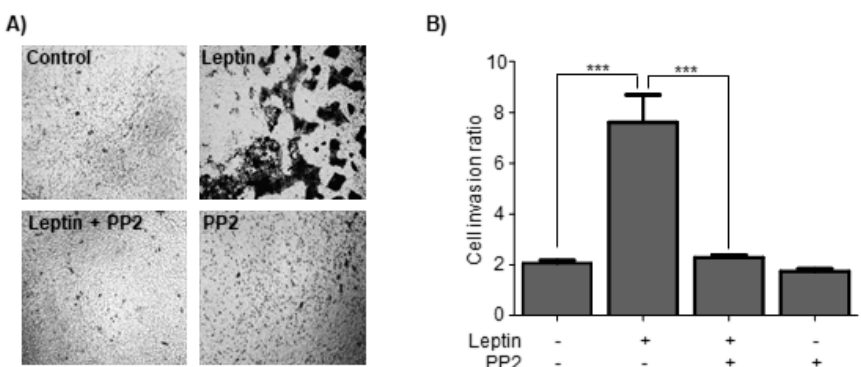
Figure 7. Leptin induce invasion in MCF10A cells in a Src-dependent manner. ( A ) Representative light microscopy images of invasion assays of MCF10A cells pre-treated with AraC and grown in the presence or absence of leptin, and the Src inhibitor PP2. ( B ) Quantitative analyses of the invasion assays presented in ( A ); the values represent the mean ± SD of three independent experiments, and are expressed as a cell invasion ratio (between invading and non-invading cells). The asterisks indicate the comparison made with respect to the control. *** p < 0.001 by a one-way ANOVA (Newman-Keuls’s test).